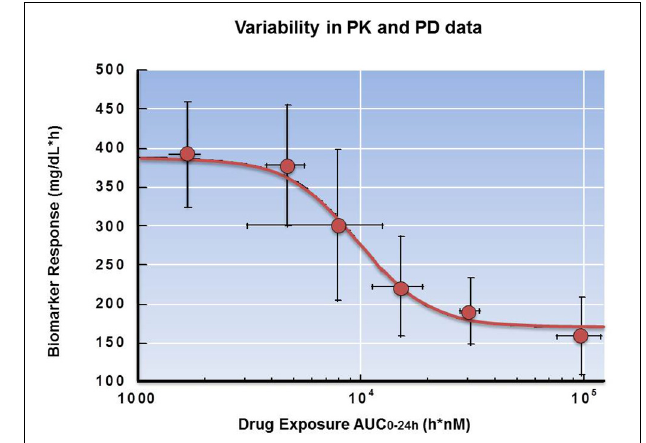
FIGURE 11 | Using multiple biomarkers to indicate modulation of the BRAF V600E pathway. A single oral dose was administered to tumor bearing mice. Plasma and tumor tissue were collected from the same mice to simultaneously obtain plasma PK and biomarker response of phospho-MEK and phospho-ERK in tumors.